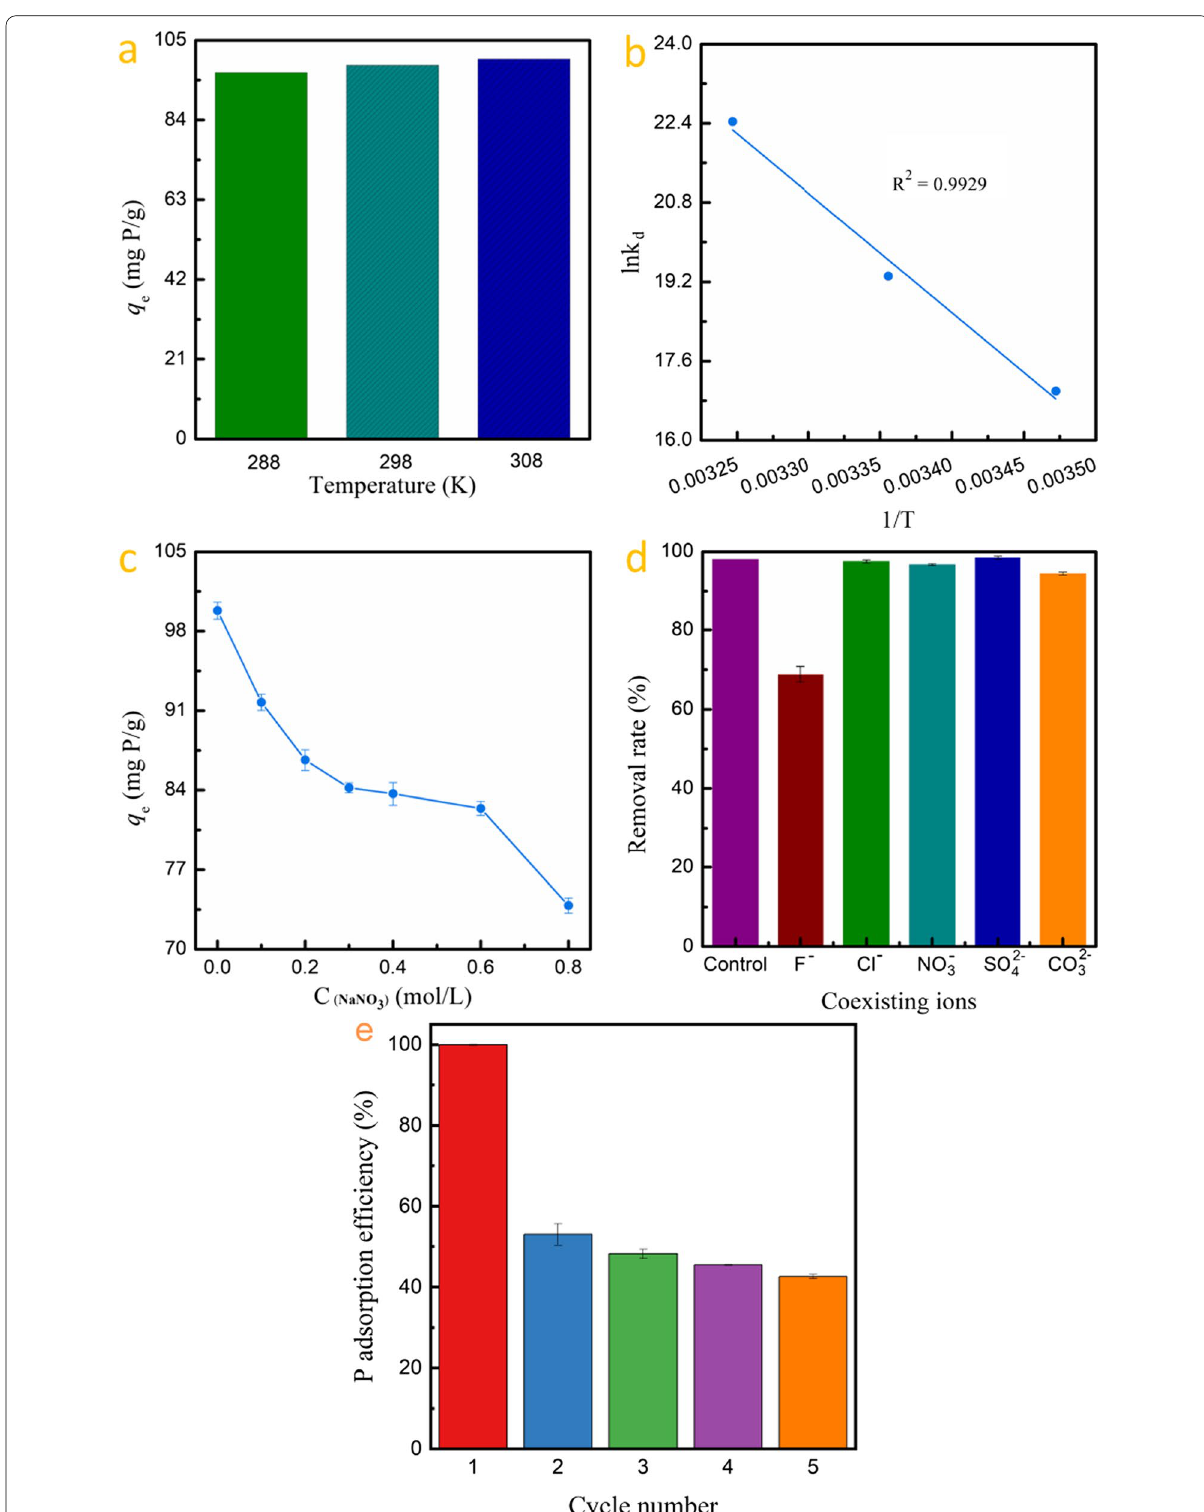
Fig. 4 a Effect of temperature on P capture, b linear plot of ln k d versus 1/ T for the thermodynamic analysis, effects of c ionic strength, d coexisting ions on P capture, and adsorbent reuse